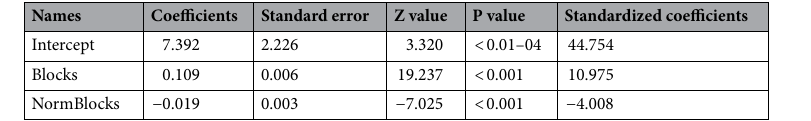
Table 1. xGA vs blocking performance (R 2 = 51.1 ± 12.1%).